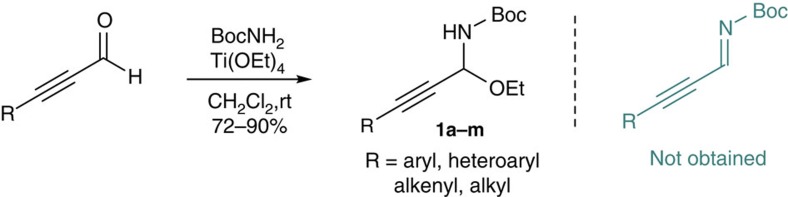
Synthesis of C-alkynyl N-Boc-N,O-acetals 1.Condition: ynal (10 mmol), BocNH2 (15 mmol), Ti(OEt)4 (15 mmol), dichloromethane (DCM) (80 ml), rt, 36 h; Boc, t-butoxycarbonyl.